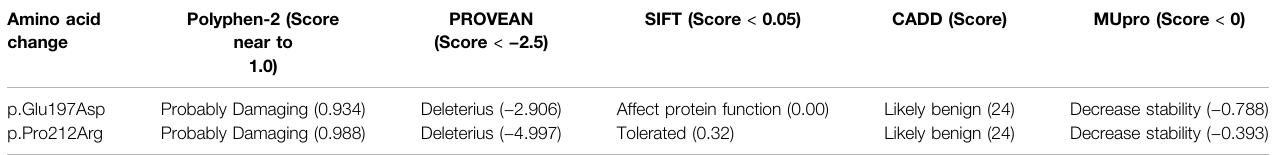
TABLE 3 | Functional predictions of amino acid changes detected in 5a-R2 in families studied. Amino acid change